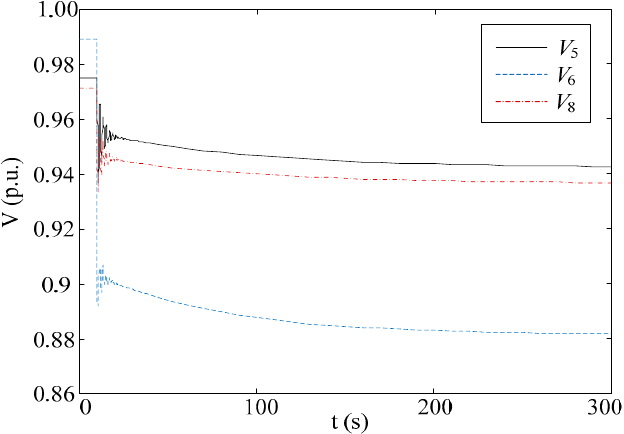
Figure 7. Voltage evolution without control in case A.